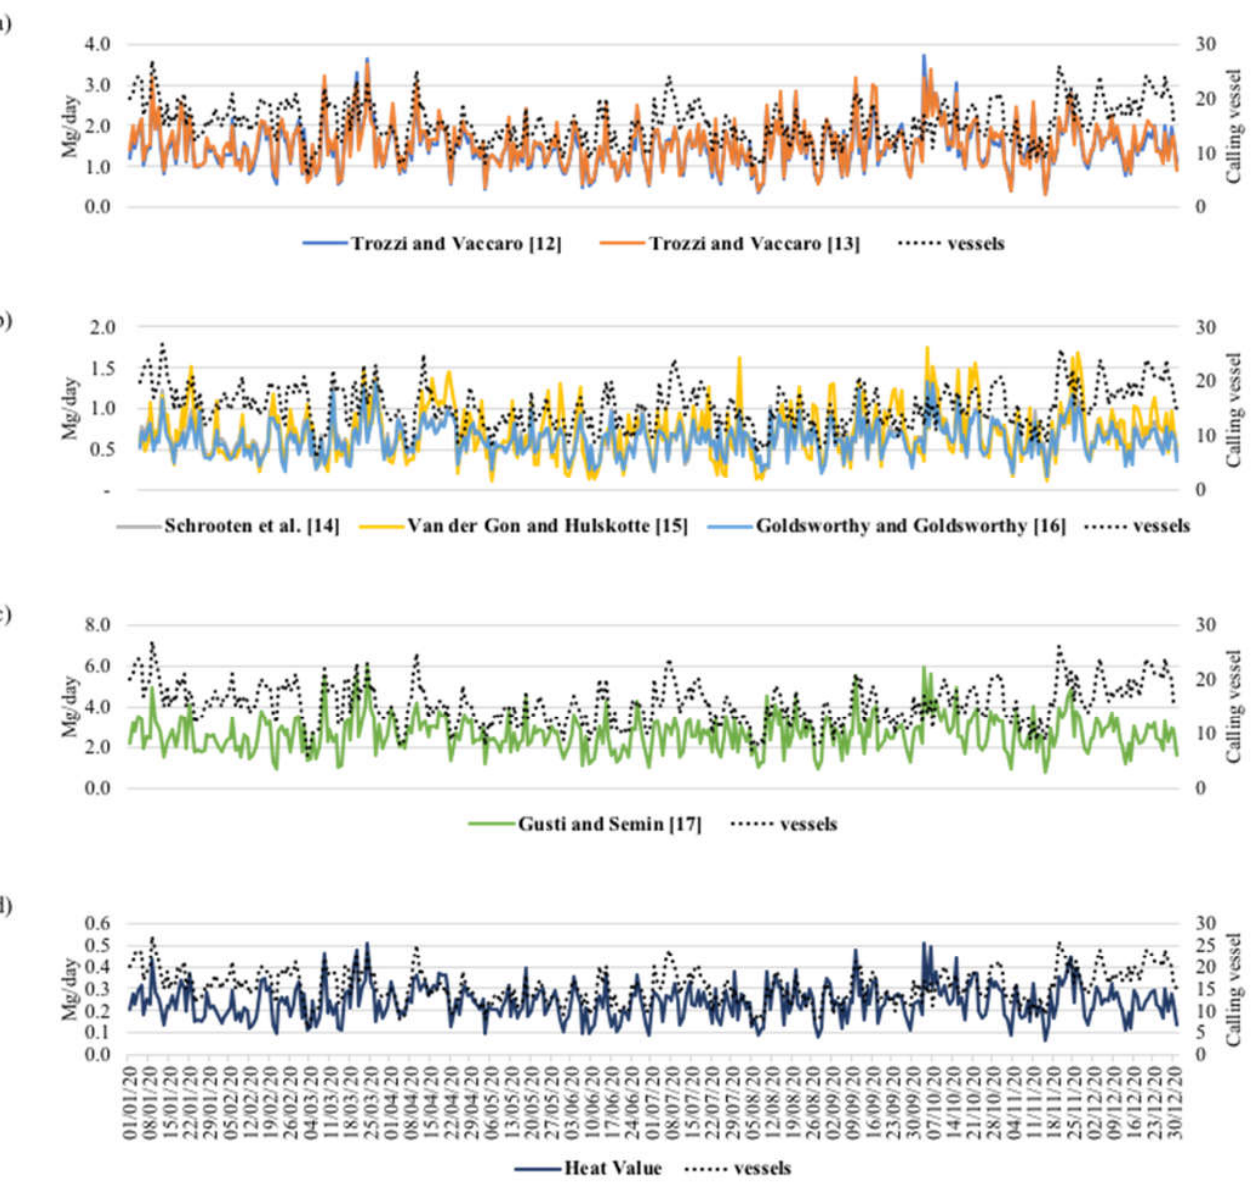
Figure 7. Atmospheric emissions according to the methods of ( a ) Trozzi and Vaccaro [12,13], ( b ) Schrooten et al. [14], Van der Gon and Hulskotte [15], Goldsworthy and Goldsworthy [16], ( c ) Gusti and Semin [17], and ( d ) Heat Value.